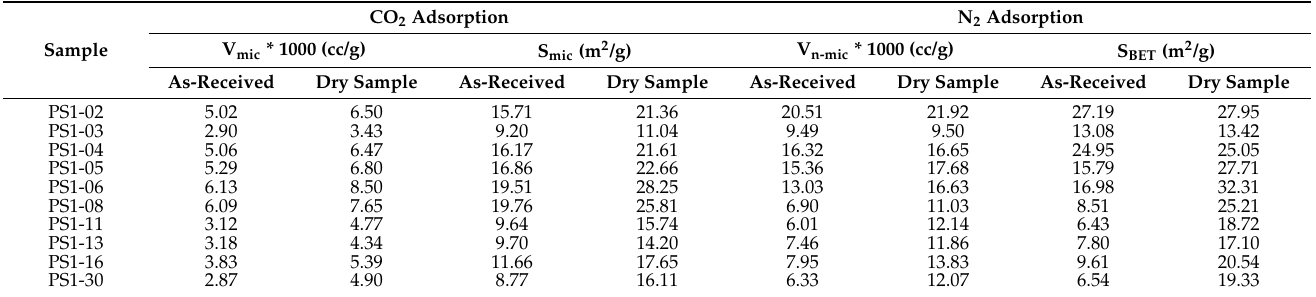
Table 2. Pore structure parameters (V mic , S mic , V n-mic , and S BET ) calculated from CO 2 and N 2 adsorp- tions of both as-received and dry shale samples from the Well PS1.